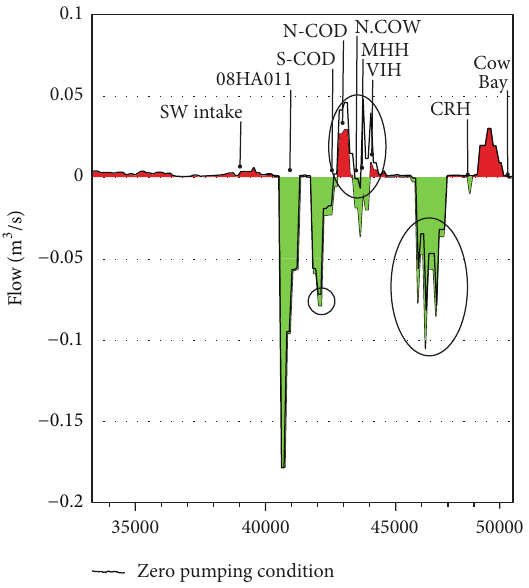
Figure 15: Comparison of pumping versus nonpumping conditions on GW/SW